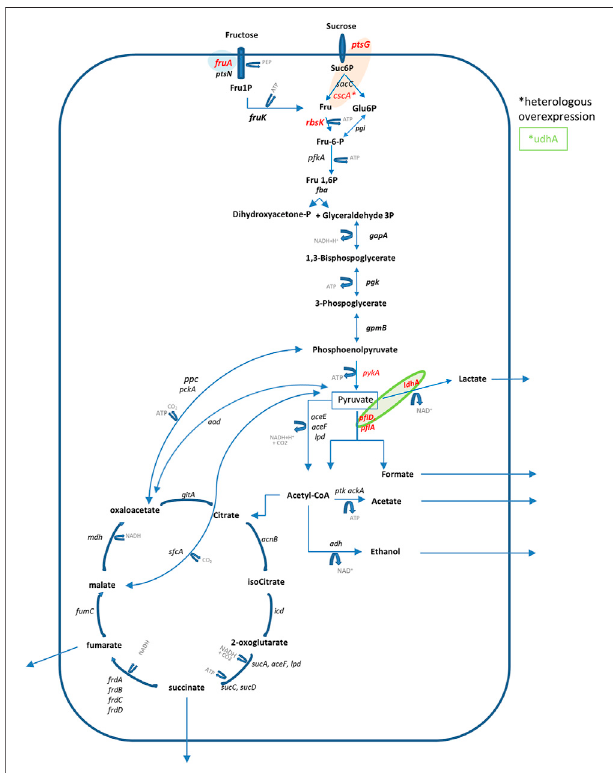
FIGURE 1 | Pathways leading to succinic acid production in B. succiniciproducens and main metabolic engineering gene targets discussed in the review. Colors indicate single or coupled gene targets. *Indicates heterologous overexpression.